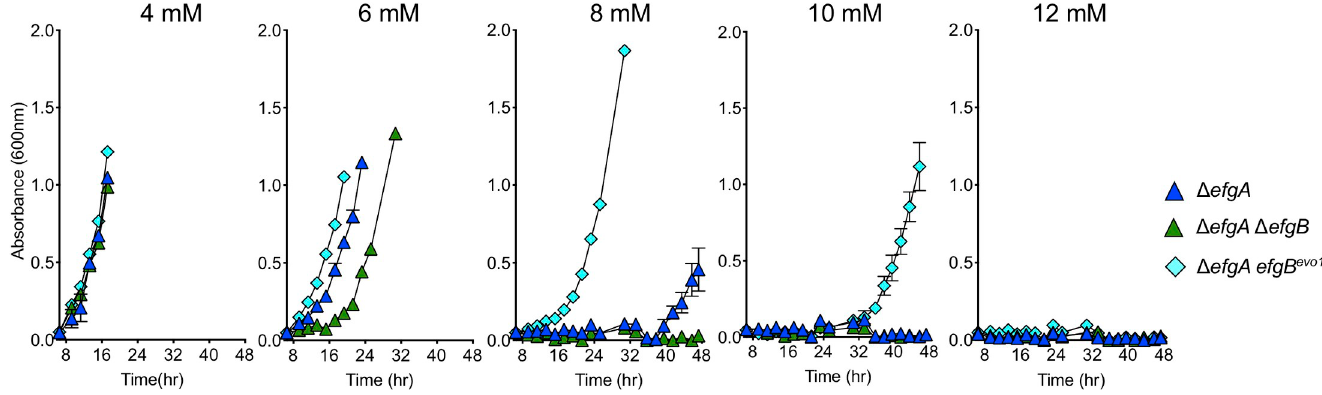
Fig 5. Formaldehyde resistance of efgA efgB double mutants indicates efgB evo1 is a gain-of-function allele. The Δ efgA (blue triangles), Δ efgA Δ efgB (green triangles), and Δ efgA efgB evo1 mutants (cyan diamonds) were grown in liquid MP medium with 15 mM succinate and 4, 6, 8, 10, or 12 mM exogenous formaldehyde. Error bars represent the standard error of the mean for three biological replicates. Growth measurements were stopped when absorbances neared the upper limits of the operational range of the spectrophotometer. The original data shown in this and all other figures are available in Supporting information file S1 Data.